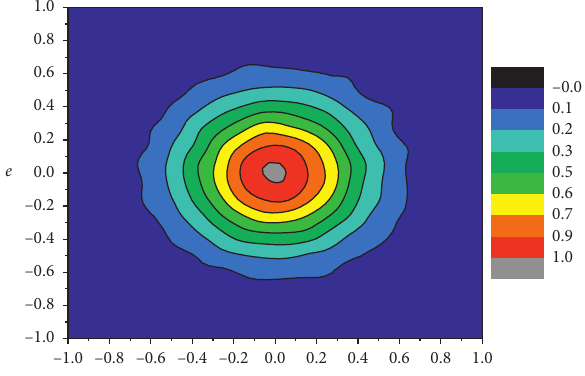
Figure 7: Input/output characteristic surface.